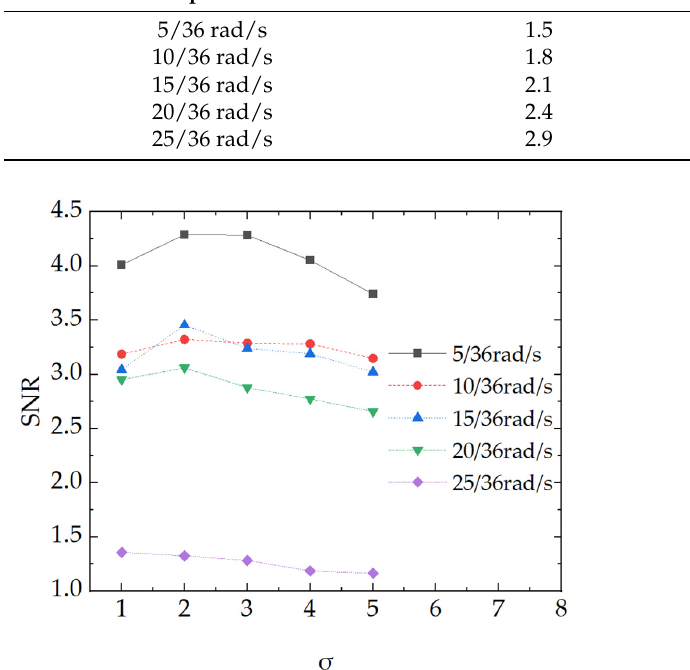
Table 1. The ratio and the optimal value of 𝜎 under different rotational speeds of the RGG.